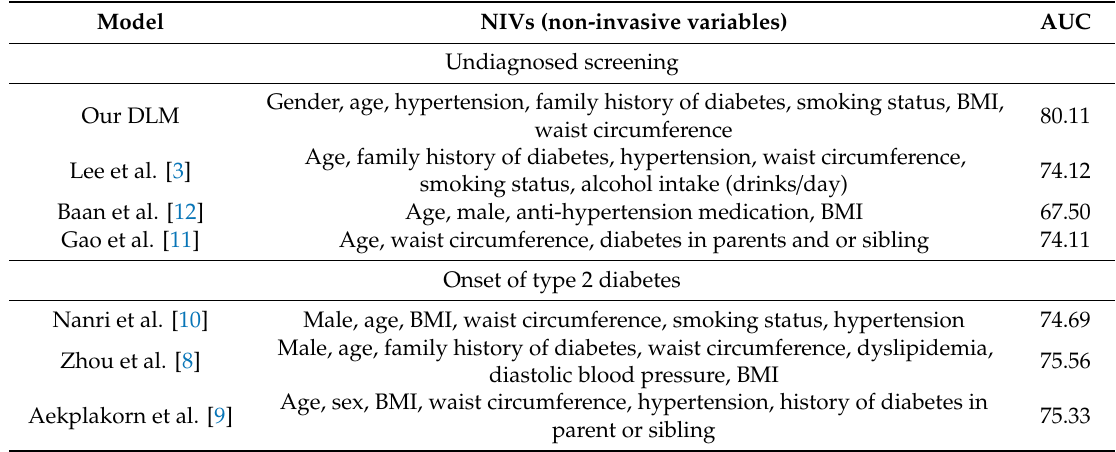
Figure 5. Comparison of AUC results among the DLM and other machine learning algorithms. Table 3. Performance evaluation for the DLM compared with other screening